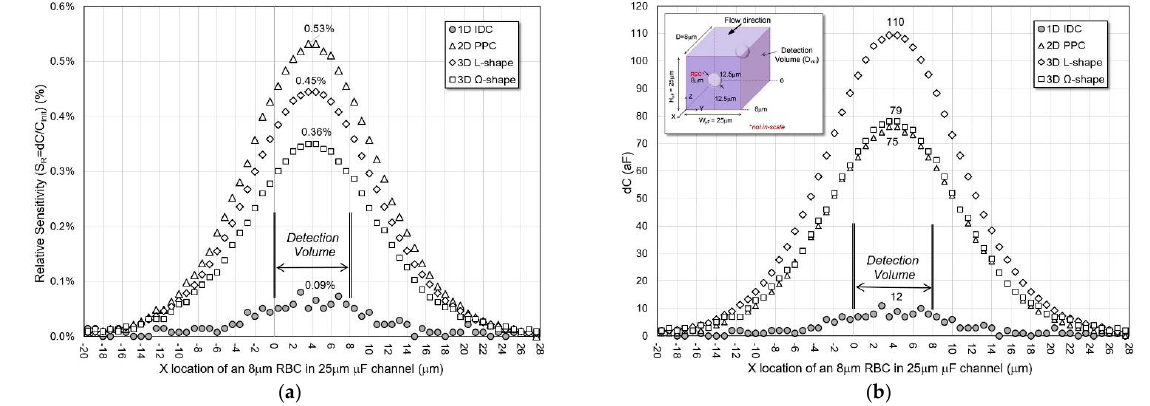
Figure 7. ( a ) Relative sensitivity and ( b ) capacitance change of the sensors for varying X-location of an 8 μm RBC cell in a 25 μm microfluidic channel.